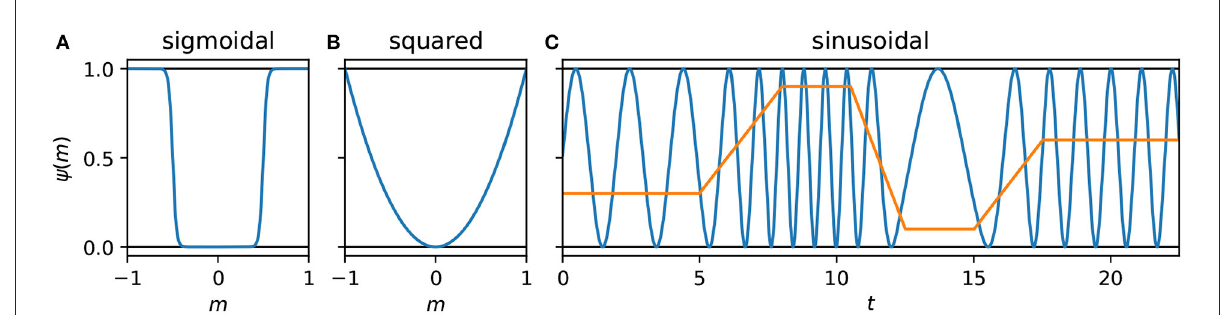
FIGURE2 Plots of the interference functions used in Experiments 2–4. (A,B) Plot pure functions of m corresponding to Equations (12) and (13) (Experiments 2 and 3, respectively). (C) Plots a function of time that depends on the cumulative history of m , Equation (14) (Experiment 4). The blue line is the interference, while the orange line is the motor activity.